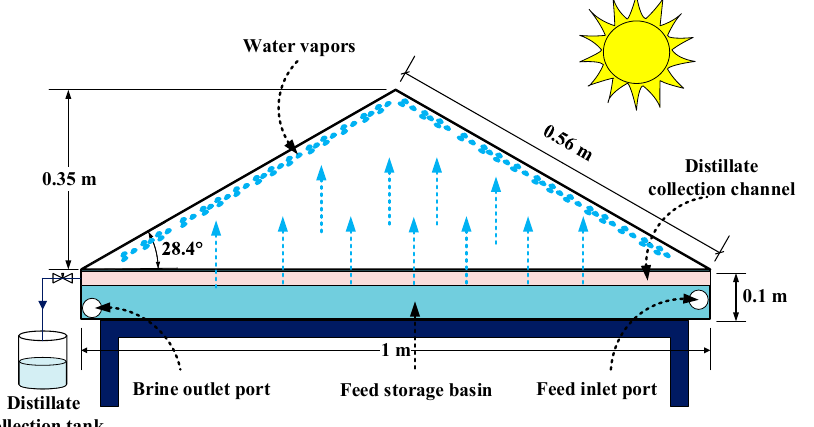
Figure 4. Schematic diagram of the pyramid solar still.